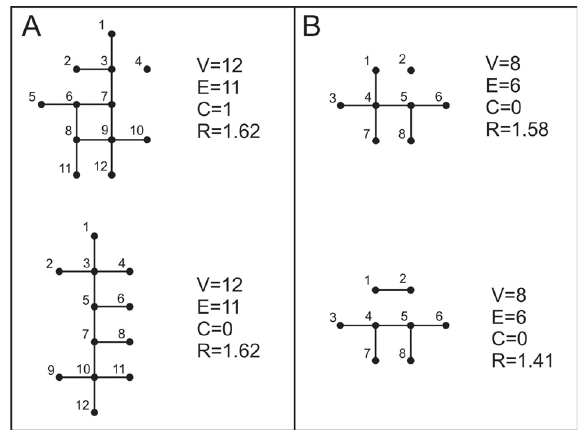
Fig. 3. Graphs differing in the number of cycles (A) or in an average rank of nodes